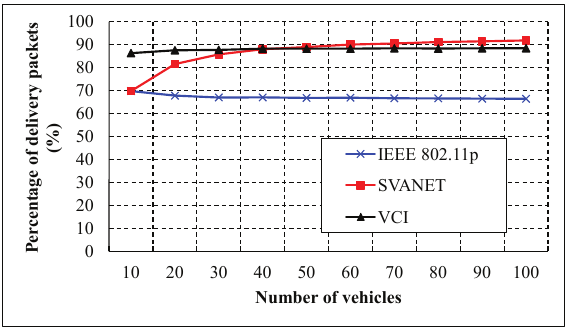
Figure 16. The percentage of safety packets delivered to the SRSU when the CCH interval varies from 1 to 100 ms.